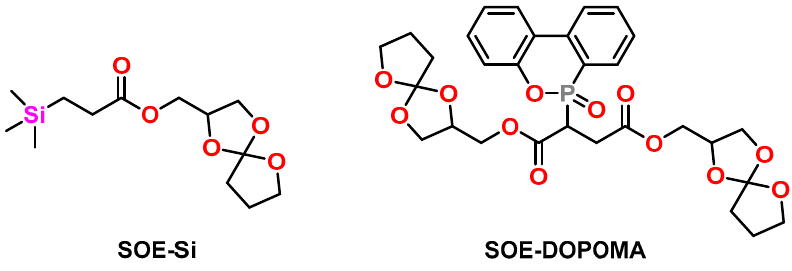
Figure 12. Chemical structure of silicon- and phosphorus-containing SOEs.